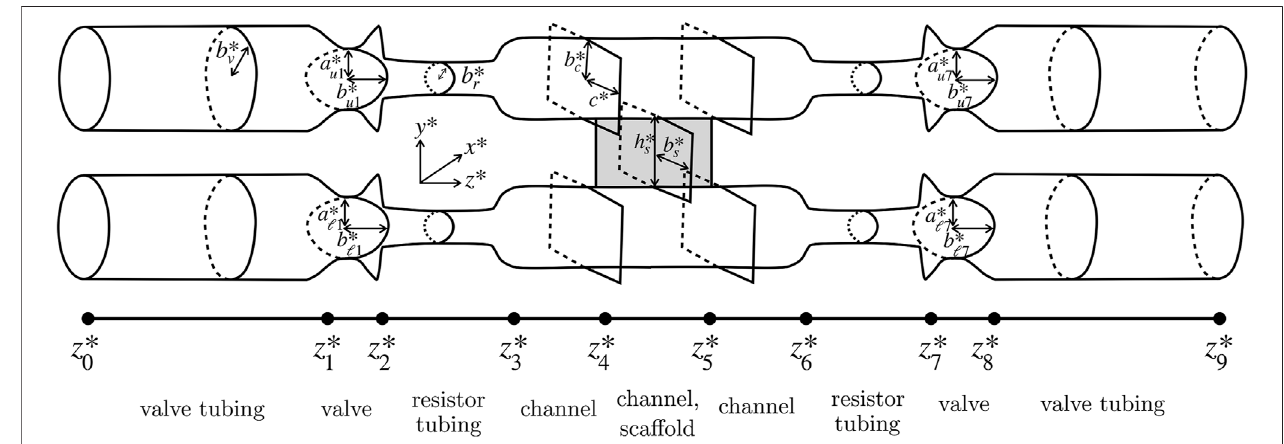
FIGURE 3 | Simpli fi ed modelling domain, showing cross-sectional shapes of each of the valve tubing, valve, resistor tubing, channel, and scaffold regions.